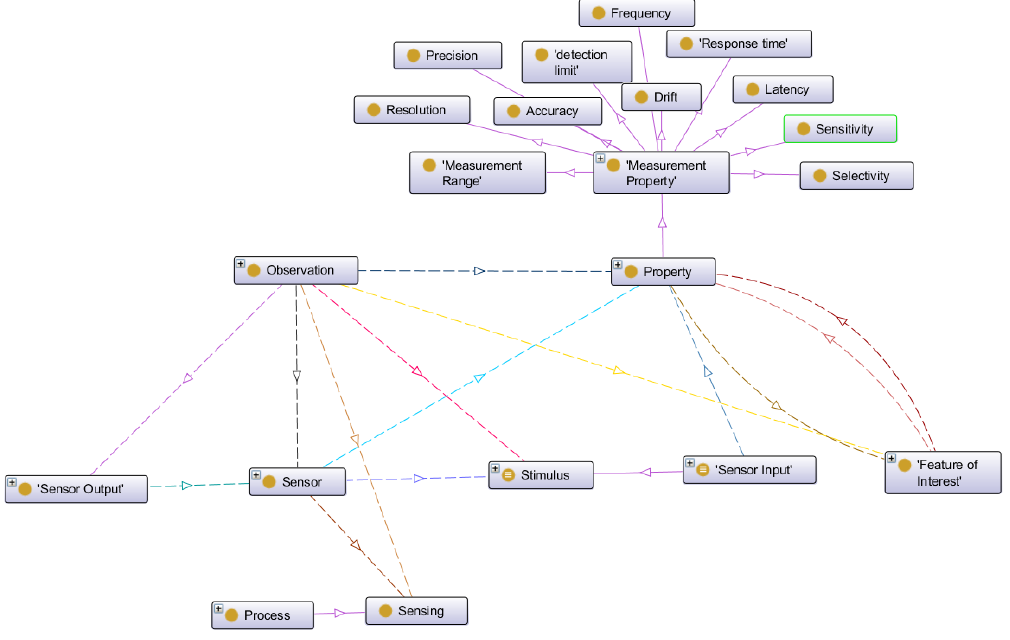
Figure 4. Skeleton of SSN ontology.